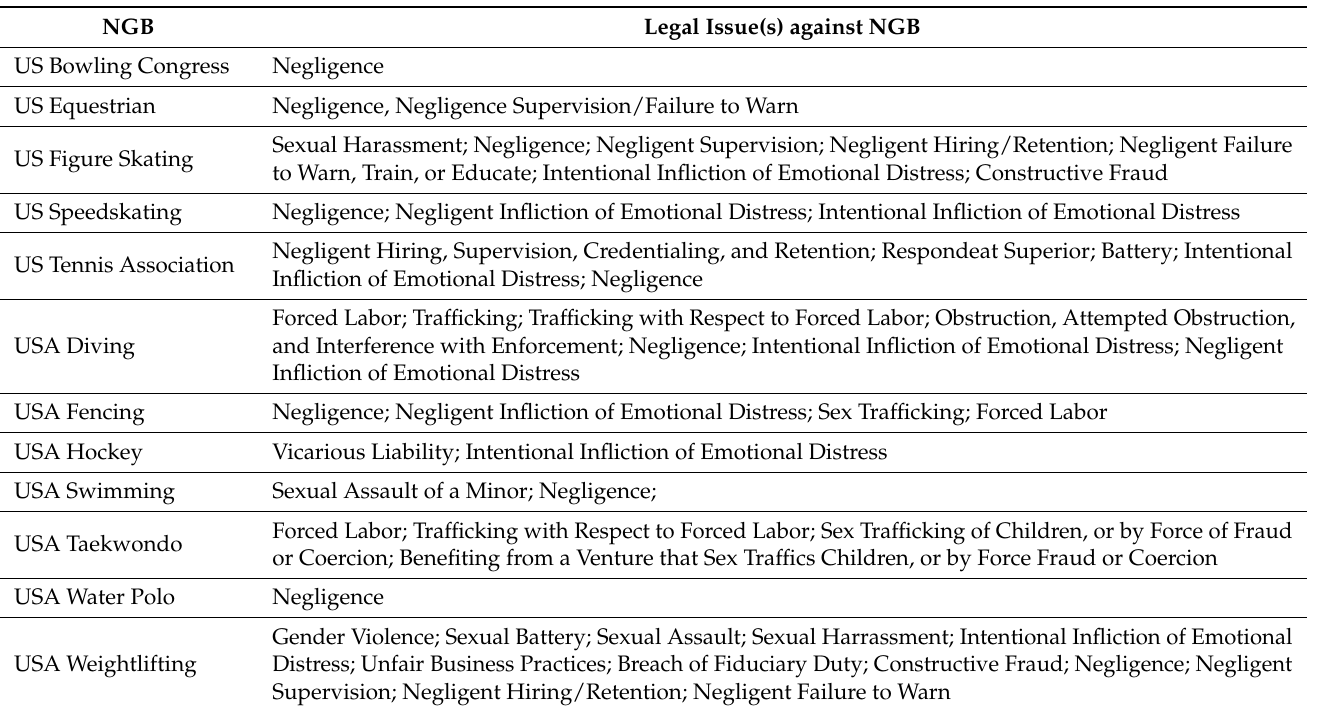
Table 2. Legal Claims Filed Against NGBs, 2017 to